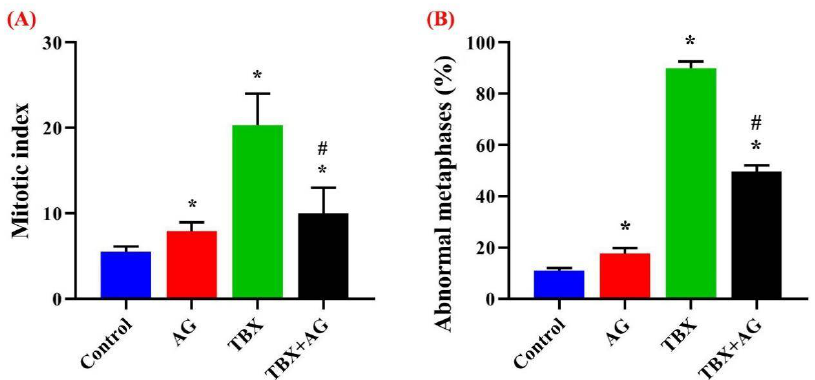
Figure 10. The protective effect of AG against TBX-induced mitotic index alterations ( A ) and the percentage of abnormal metaphases ( B ) in the bone marrow of treated rats after 24 h of treatments. *: Significant ( p < 0.001) relative to untreated groups. #: Significant ( p < 0.001) relative to TBX- treated groups. Data were represented as mean ± SE of three independent experiments ( n = 5). AG: 10% Arabic gum, TBX: Telebrix (1600 mg I/kg b.wt.) and TBX+AG: co-treatment with 1600 mg/kg b.wt. and 10% Arabic gum.